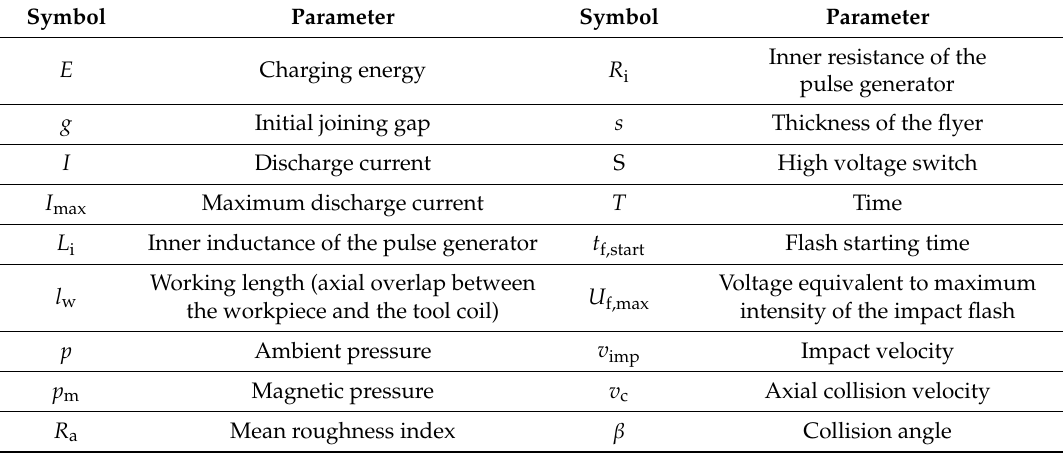
Table 1. Nomenclature for experimental